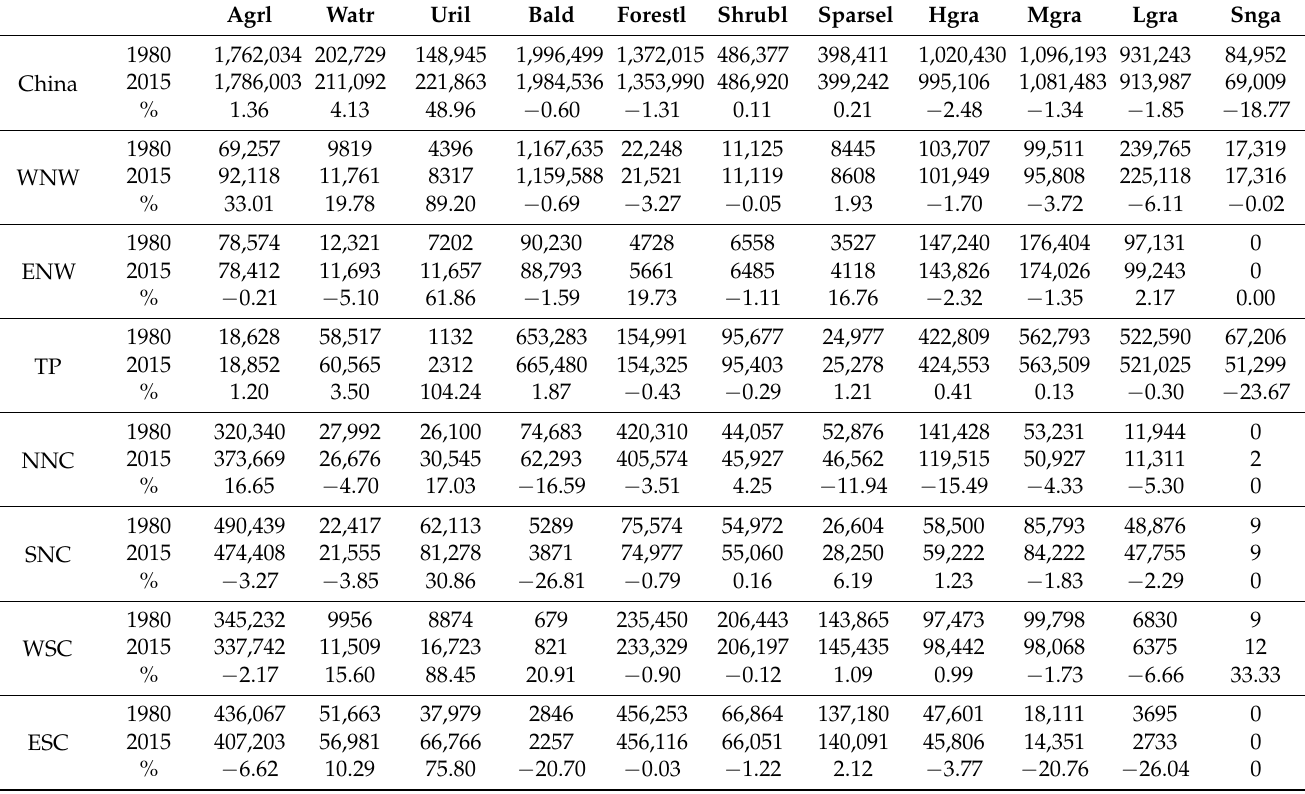
Table 1. The areas and relative changes to different land use/land cover (LUCC) in China from 1980 to 2015. Agrl Watr Uril Bald Forestl Shrubl Sparsel Hgra Mgra Lgra